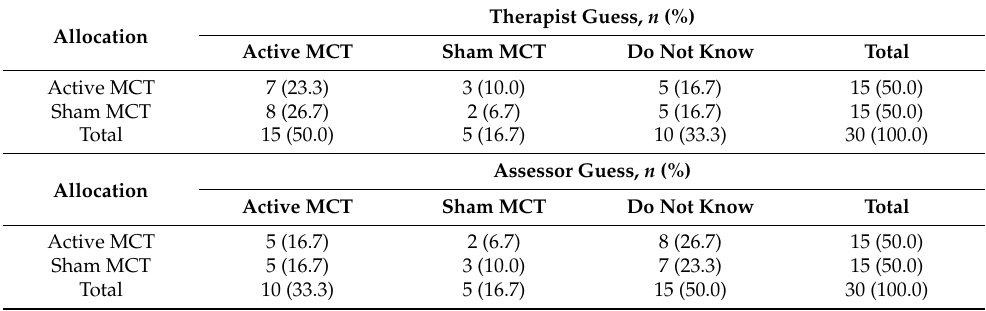
Table 4. Guesses of therapists (upper) and assessors (lower) about group allocations. MCT: microcur- rent therapy.